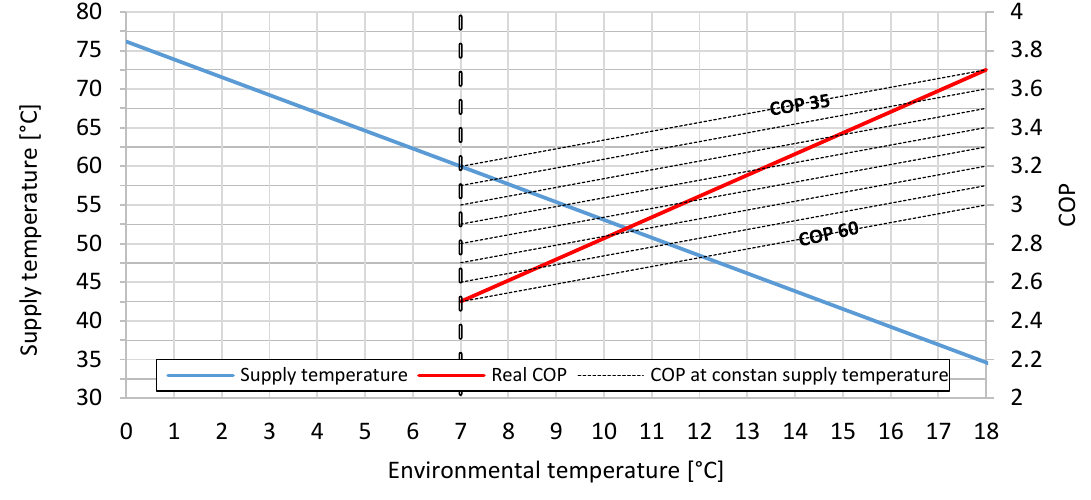
Figure 3. Coefficient of performance (COP) dependency from the working temperatures.